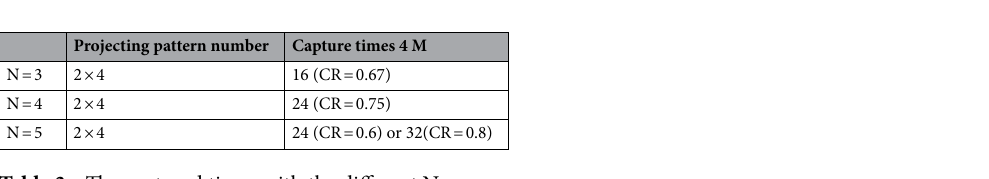
Table 3. The captured times with the different